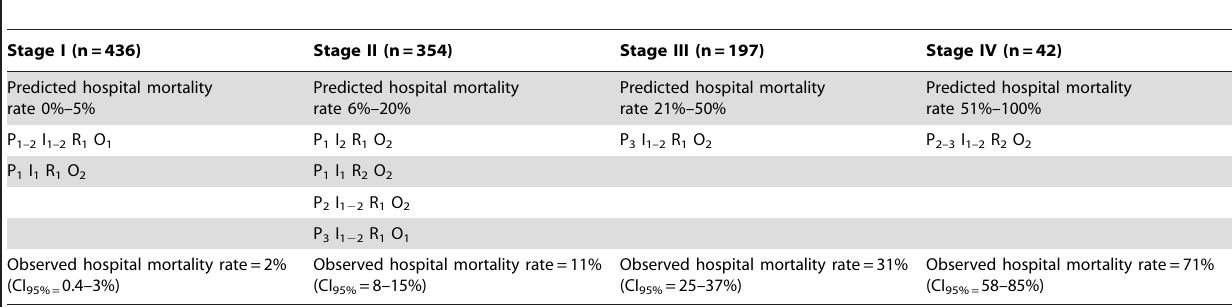
Table 7. Clinical staging system for hospital mortality in patients with infection according to the total score in each PIRO component in the derivation cohort (n=1035).